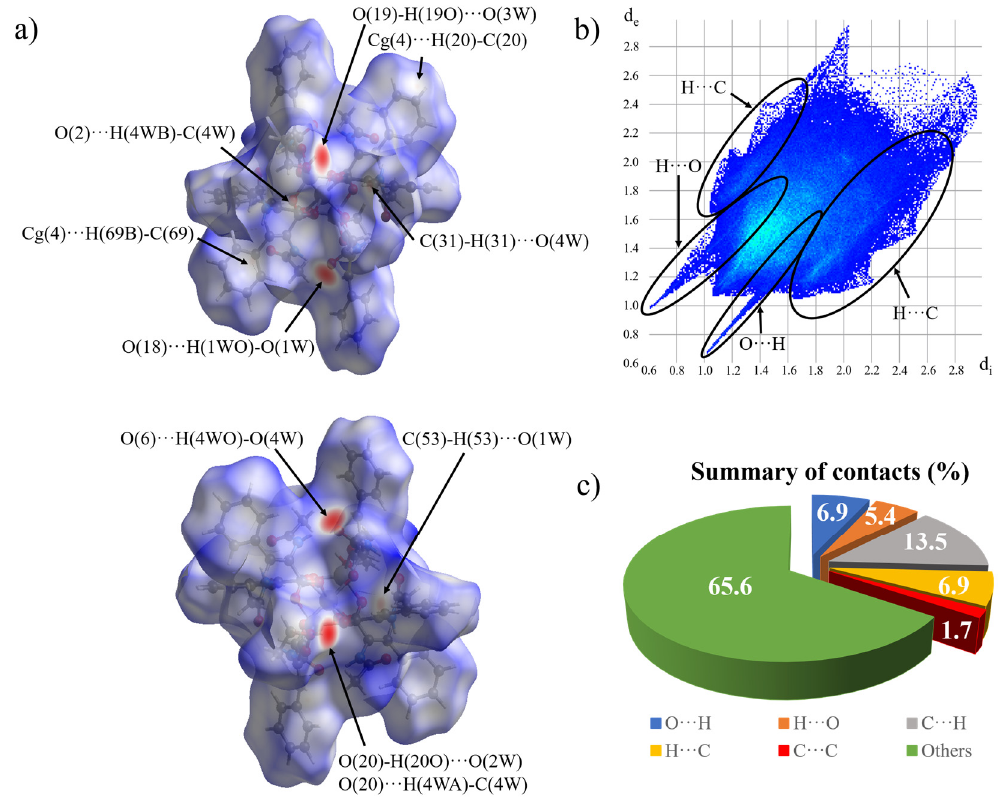
Figure 8. ( a ) Hirshfeld surface d norm representations, ( b ) 2D fingerprint plot highlighting the intermolecular interactions, and ( c ) graphical summary of the percentage of each contact involved in the Hirshfeld surface of 3 ·4EtOH.